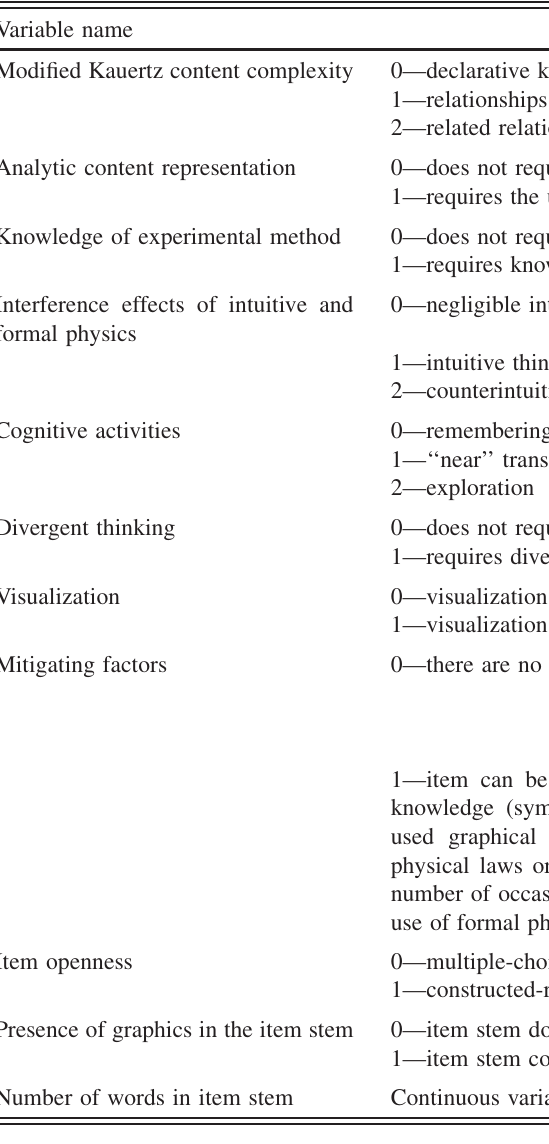
TABLE II. Potential predictors of item